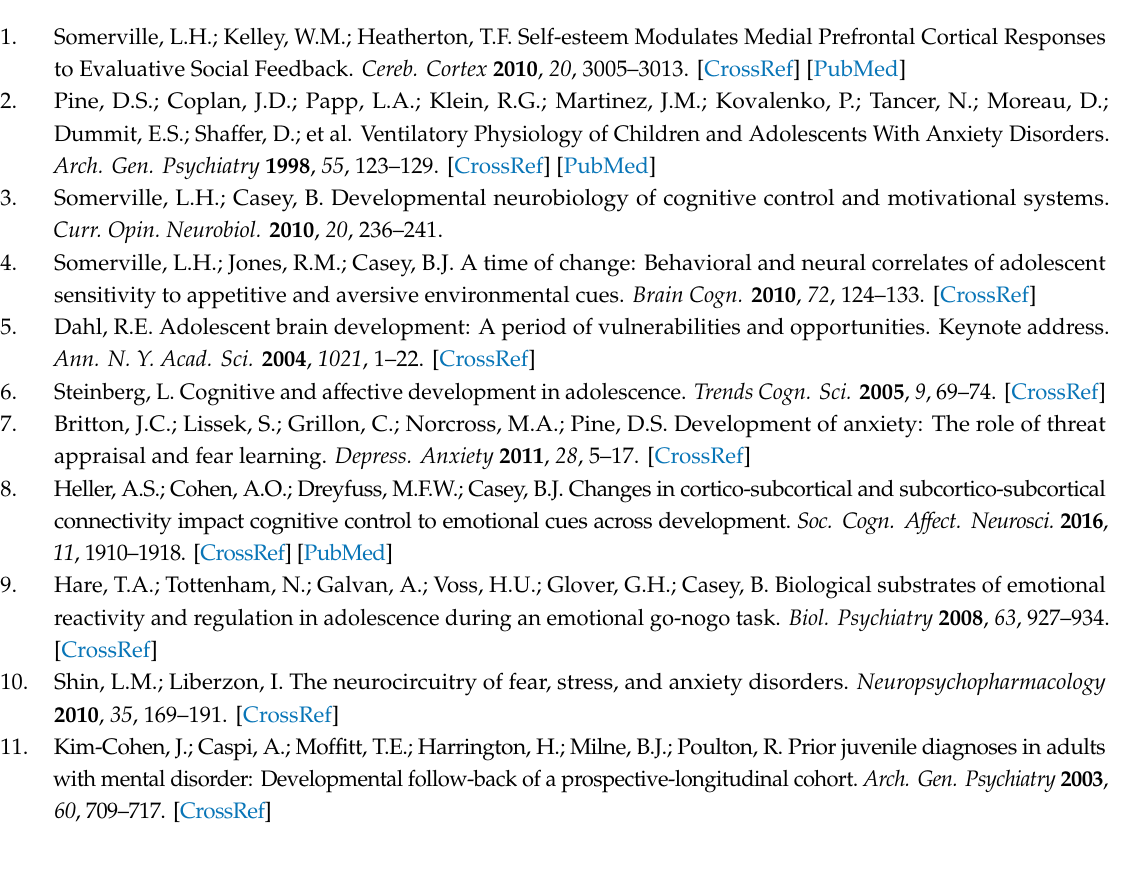
Figure S1: Fear conditioning behavioral data across extinction learning and the two extinction recall sessions, sorted on genotype, Figure S2: Fear conditioning behavioral data across extinction learning and the two extinction recall sessions, including baseline, Figure S3: Correlational plots showing associations between brain gene expression levels and behavioral